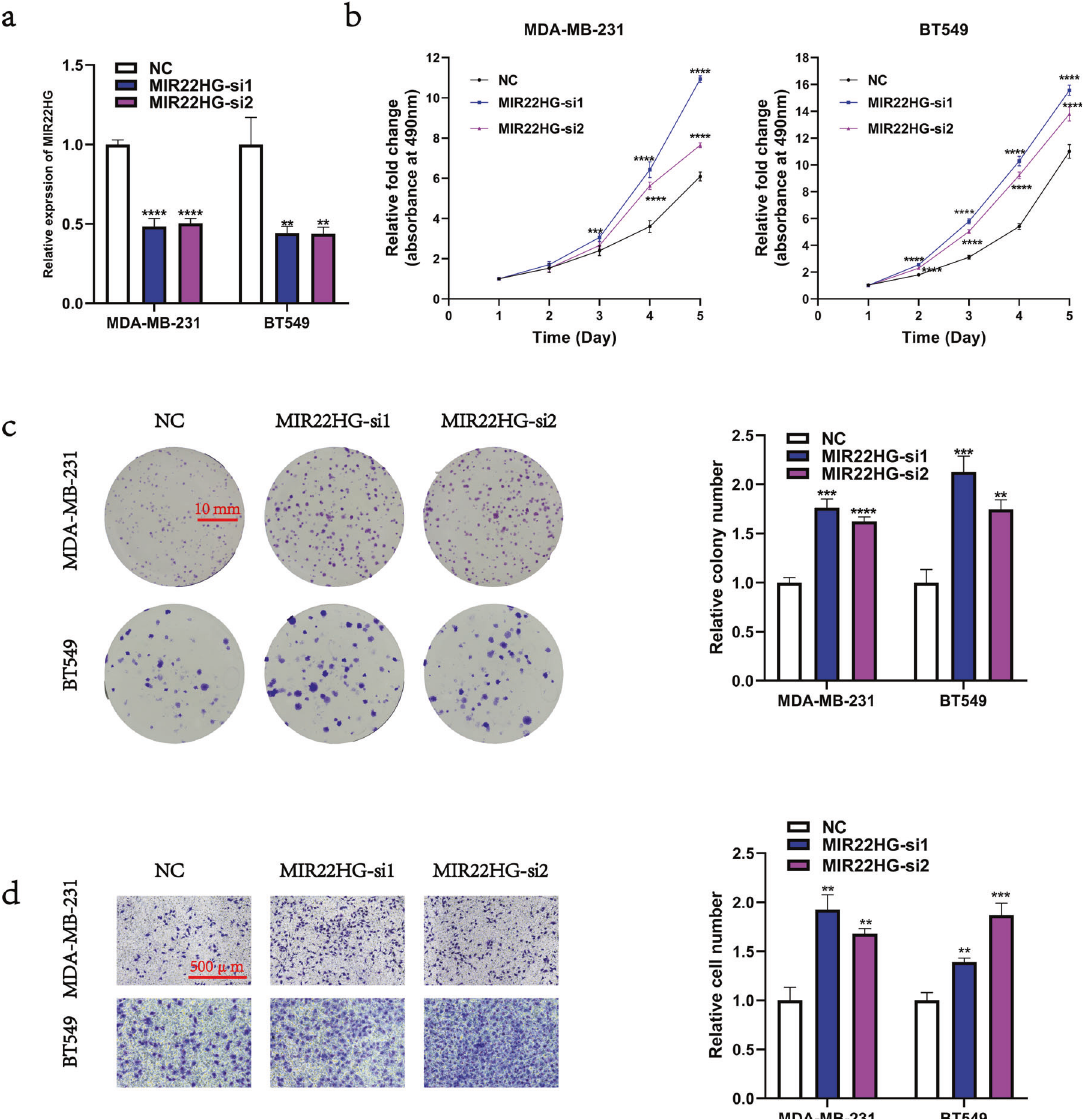
Fig. 2 Loss-of-function of MIR22HG promotes the proliferation and migration of breast cancer cells. a Knockdown ef fi ciency was detected by real-time PCR after transfection of MDA-MB-231 and BT549 cells with siRNAs targeting MIR22HG ( MIR22HG -si1 and MIR22HG -si2) or negative control (NC) for 48 h. b , c MTT assay (5-day period) and colony formation assay (18-day period) were used to determine the viability of MDA- MB-231 and BT549 cells after MIR22HG knockdown. d Transwell assay (20-h period, 3 × 10 4 cells per well) was performed to evaluate the migration ability of MDA-MB-231 and BT549 cells after MIR22HG knockdown (100 × magni fi cation). ** P < 0.01, *** P < 0.001, **** P < 0.0001. All experiments were repeated